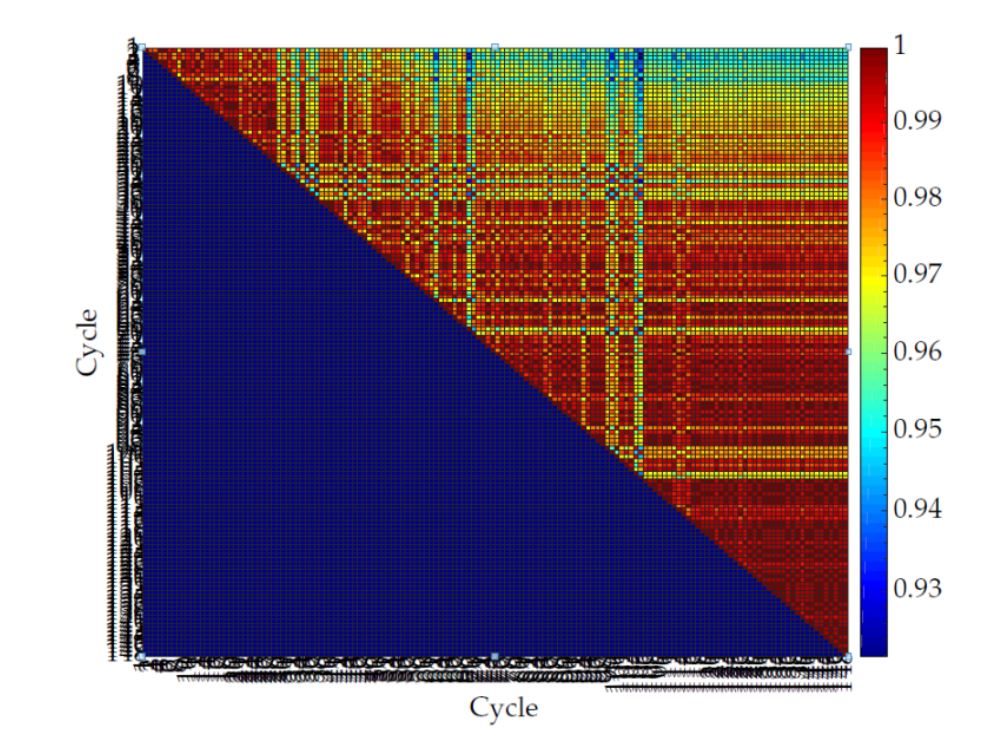
Figure 26. Normalized cross-correlation between sinusoidal motions for a band with a high iteration frequency (30 cycles/min) and low stretch length (0.5 mm).